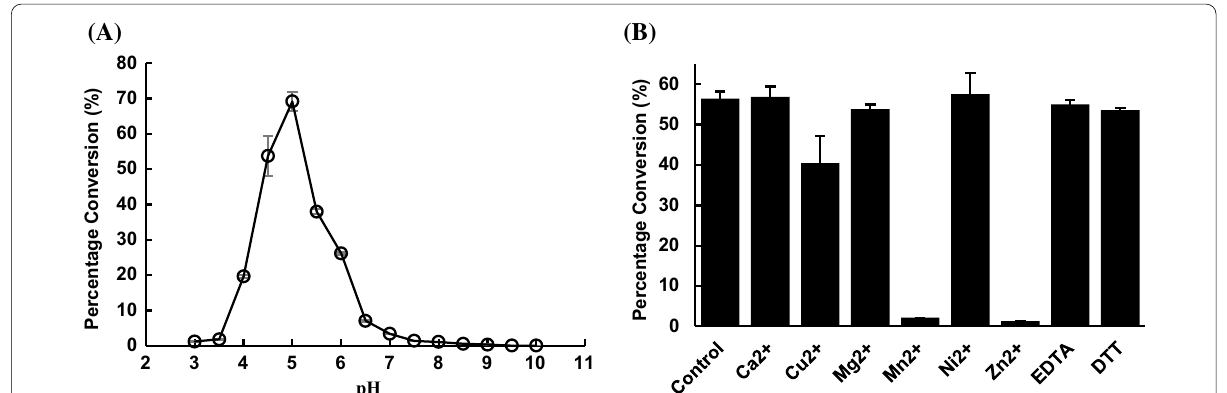
Fig. 5 pH profile ( A ) and the effects of divalent metal ions, EDTA, and DTT on the activity of ∆22Bt3590 ( B )